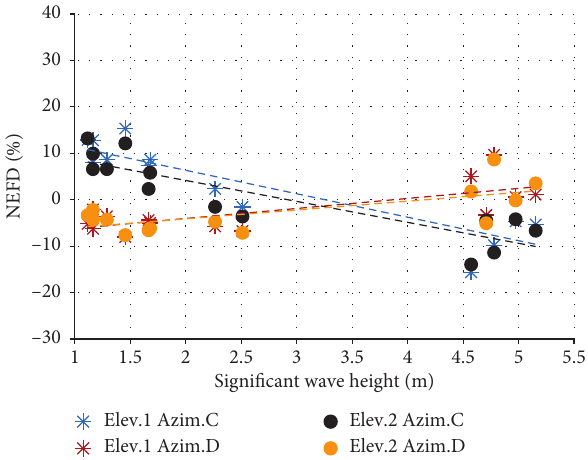
Figure 13: Normalized error of fatigue damage (NEFD) based on optimal azimuth